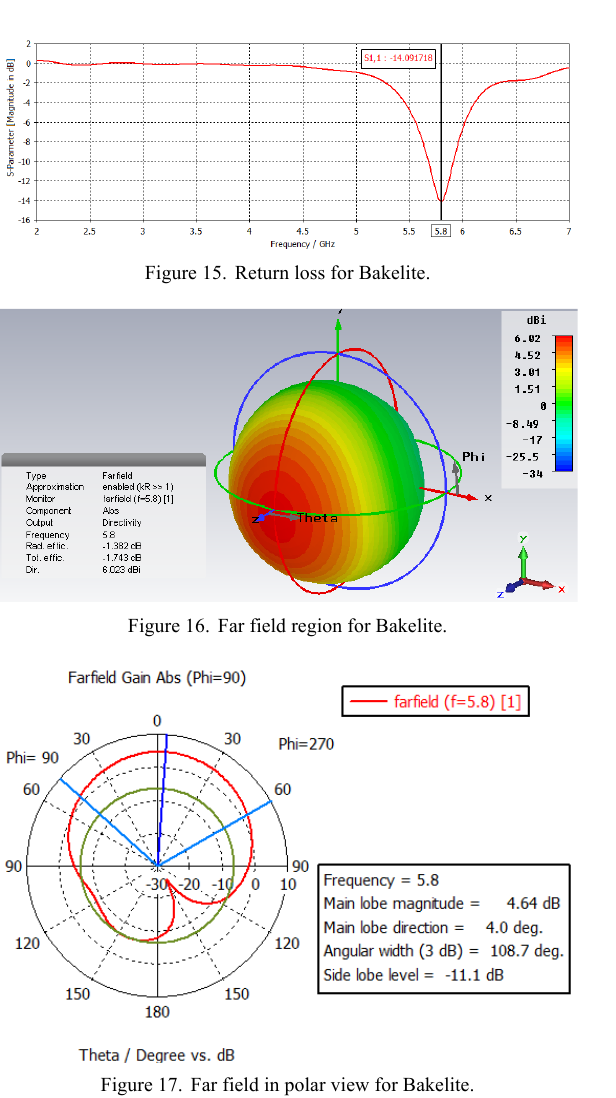
Figure 17. Far field in polar view for Bakelite.